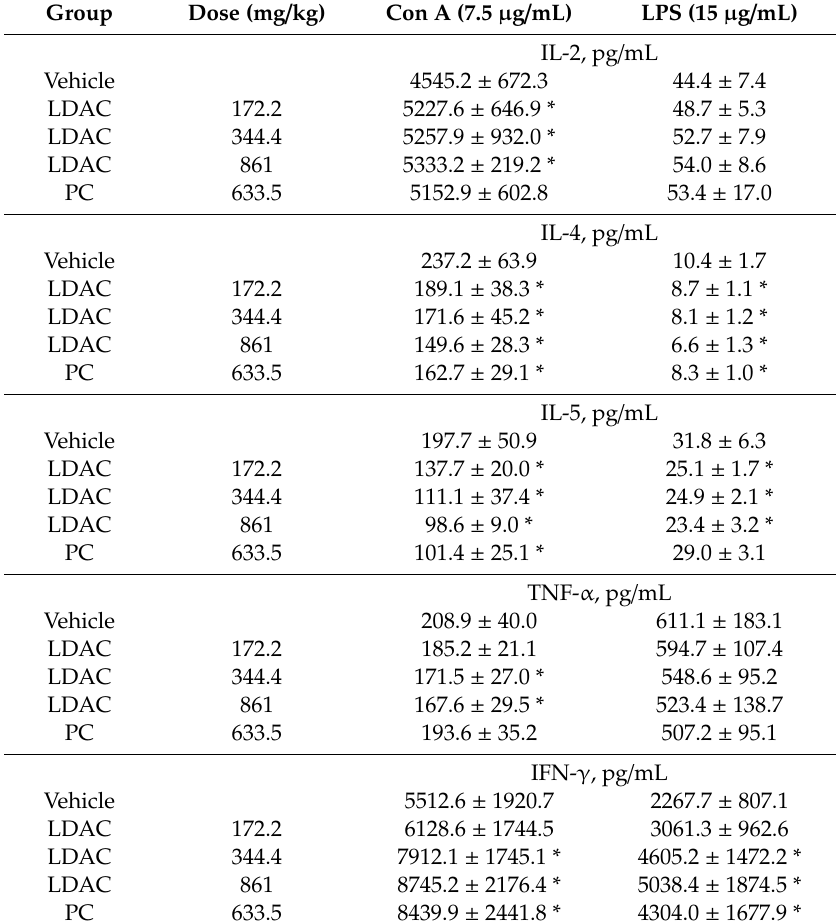
Table 2. E ff ect of Leader Deluxe Taiwanofungus camphoratus capsule (LDAC) on cytokines secretion in non-specific immune response.